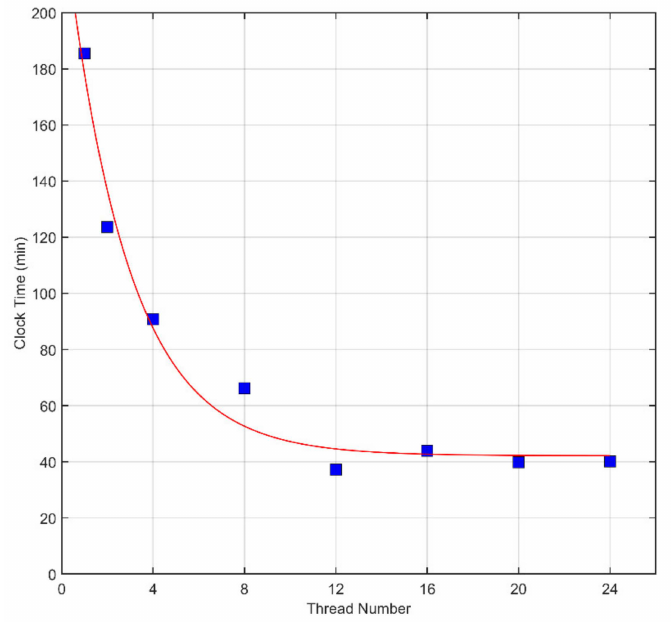
Figure 17. Clock time versus thread numbers of the workstation. It is noted that 2 threads are equal to 1 CPU. The blue rectangles indicate the clock time using different numbers of threads. The red line is the curve-fitted result: y = 42.16 + 196.3 × exp ( − 0.365 x ) , and x and y here imply the x and y -axis of this